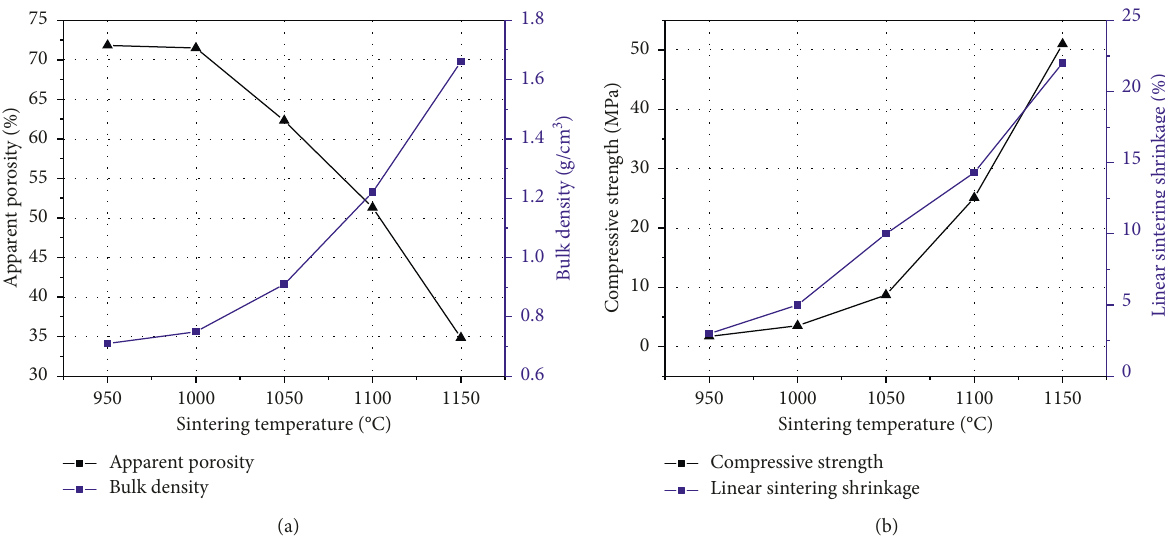
Figure 10: The influence of the sintering temperature on (a) the apparent porosity and bulk density and (b) compressive strength and linear sintering shrinkage of as-sintered ceramics for the second-stage sintering